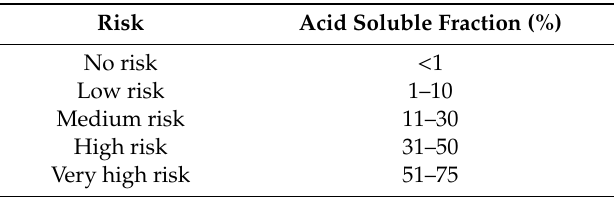
Table 2. Classification of risk assessment code